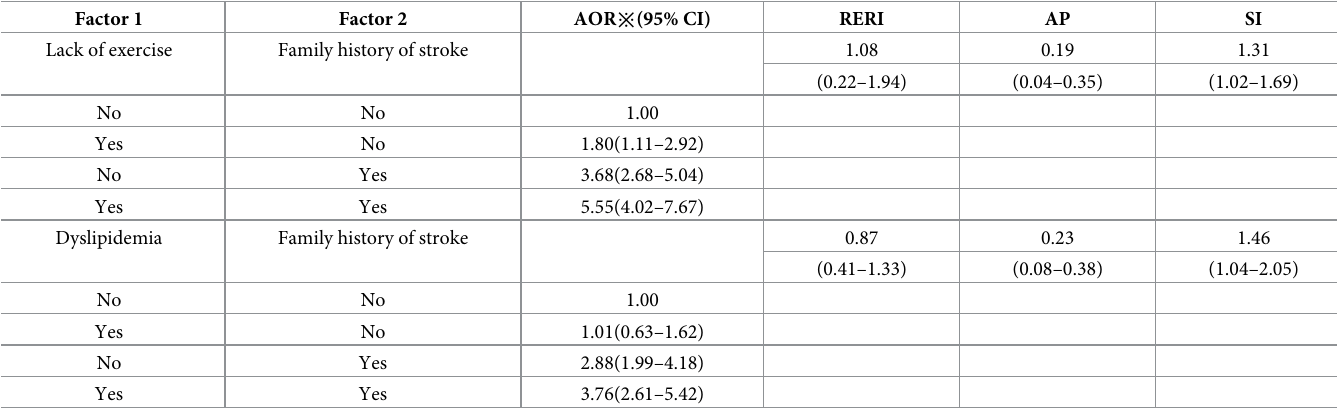
Table 4. Analysis of additive interaction of influencing factors of